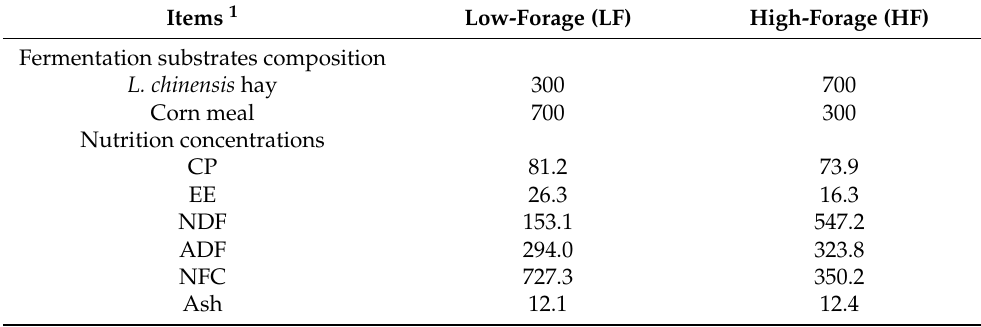
Table 1. Composition and nutrient concentrations of fermentation substrates in experiment (g/kg